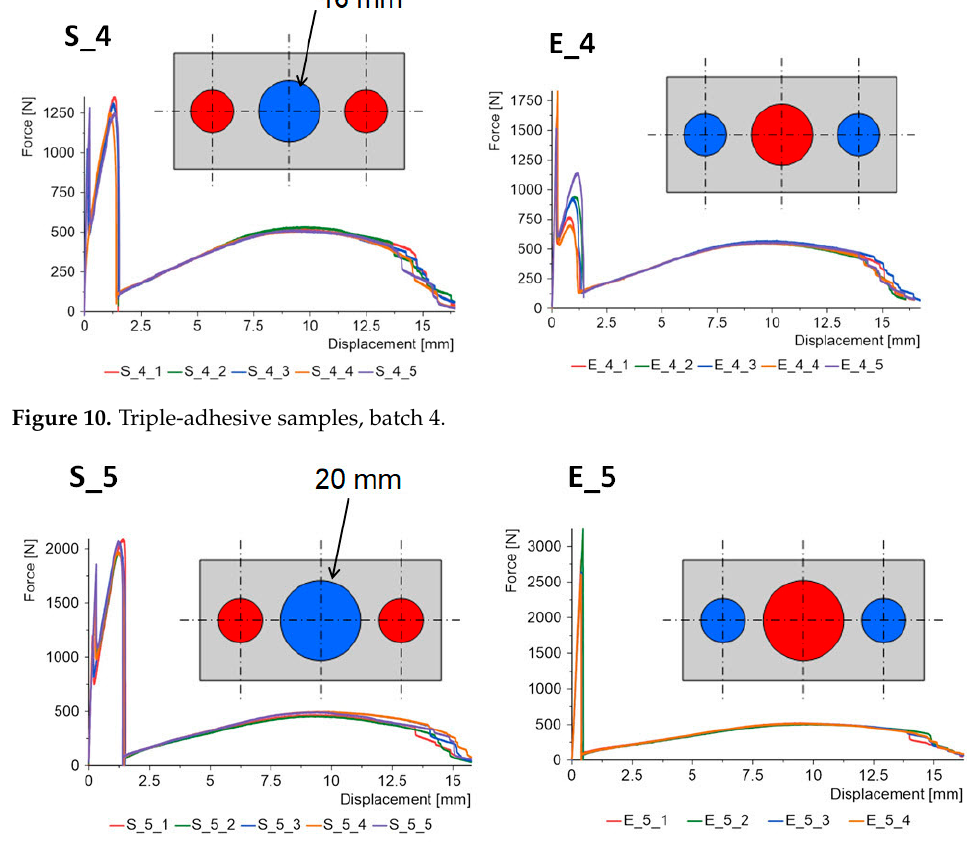
Figure 11. Triple-adhesive samples, batch 5.